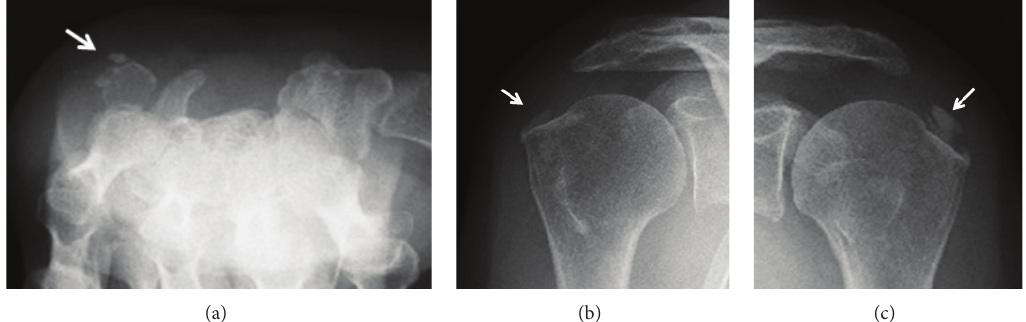
Figure 2: Calcification was observed on the contralateral wrist joint (a) and bilateral shoulder joints (b, c).